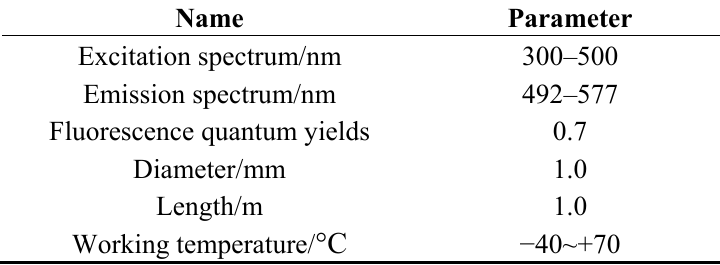
Table 1. Characteristic parameters of the fluorescent fiber sensor.